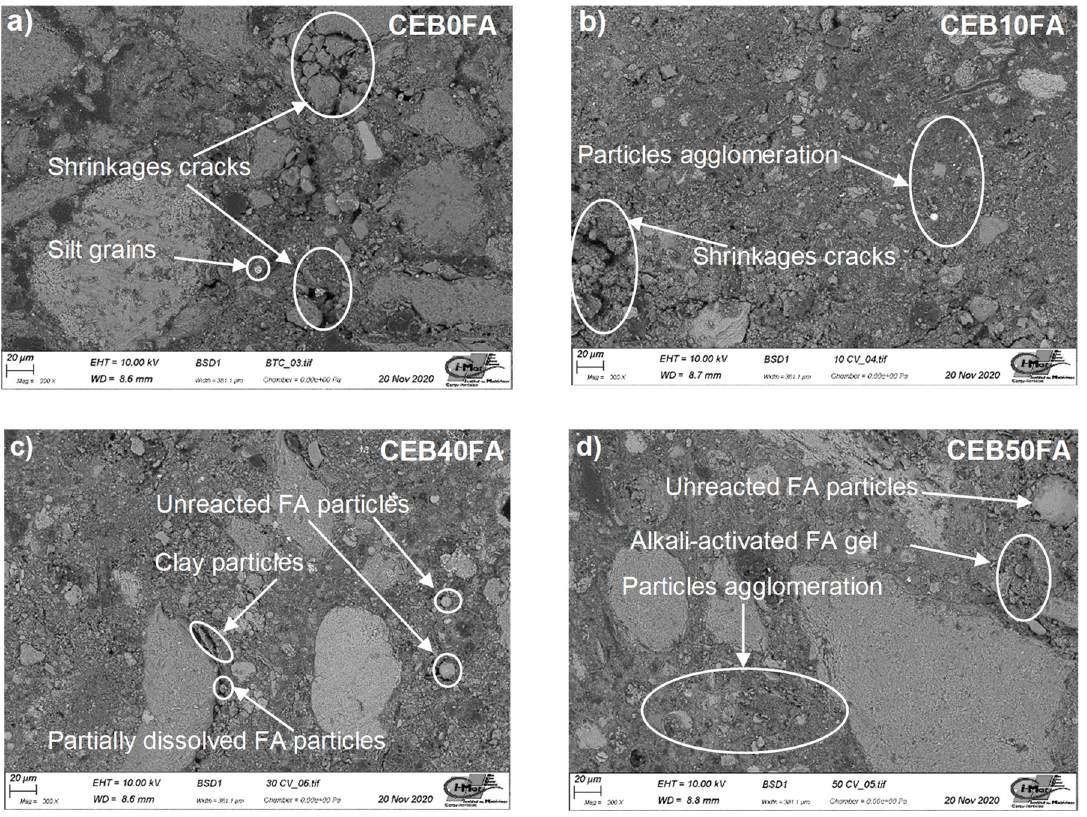
Figure 5. SEM images of CEBs: ( a ) CEB0FA; ( b ) CEB10FA; ( c ) CEB40FA; and ( d ) CEB50FA.